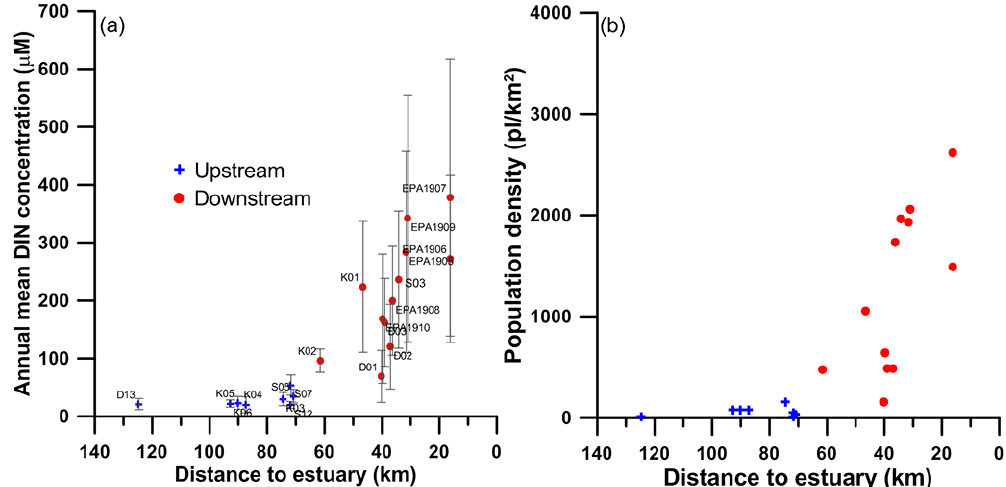
Figure 2. Longitudinal distributions of (a) measured DIN concentration and (b) population density along the Danshui River. Bars in (a) represent the standard deviation of measurements. The blue crosses and red circles indicate the upstream and downstream sites, respectively. Table 3. The correlation matrix among population density, runoff and land use composition. The Pearson correlation coefficients are shown. The observed DIN concentrations are grouped into two subsets: upstream and downstream data. Pop (capkm − 2 ) Q (mm) Building (%) Agri. (%) Forest (%) Water (%) Bare (%) Pop (capkm − 2 ) −